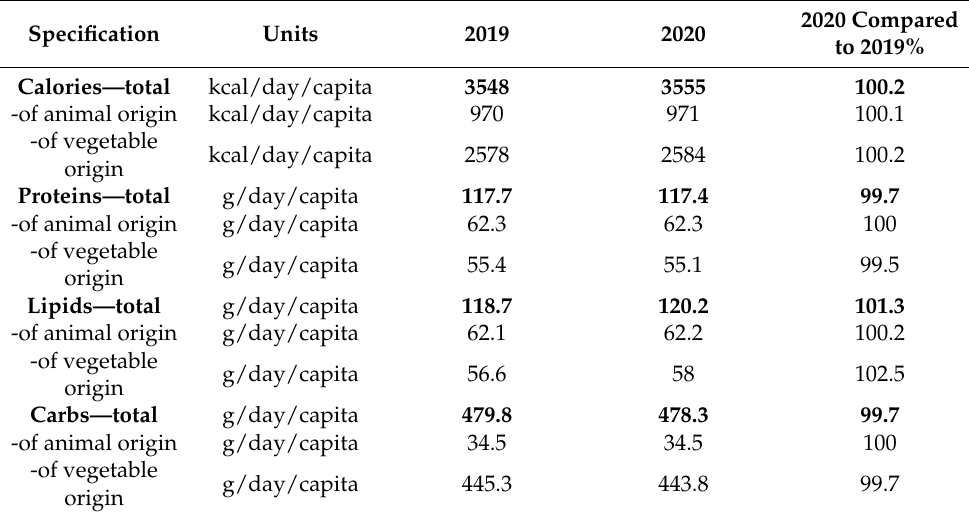
Table 3. Average daily food consumption per inhabitant, expressed in calories and nutritional factors, in 2020 compared to 2019 in Romania [39].